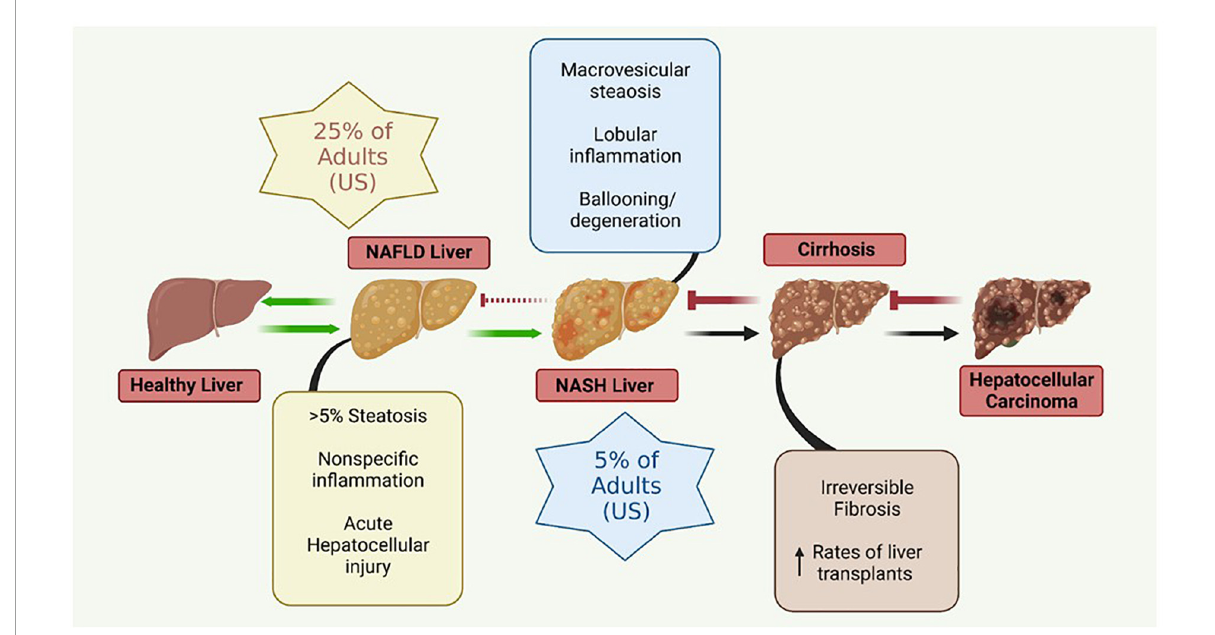
FIGURE2 Metabolic liver disease is a multifactorial, progressive disease that if left untreated can lead to irreversible conditions necessitating liver transplantation. NAFLD, non-alcoholic fatty liver disease; NASH, non-alcoholic steatohepatitis. Figure created with